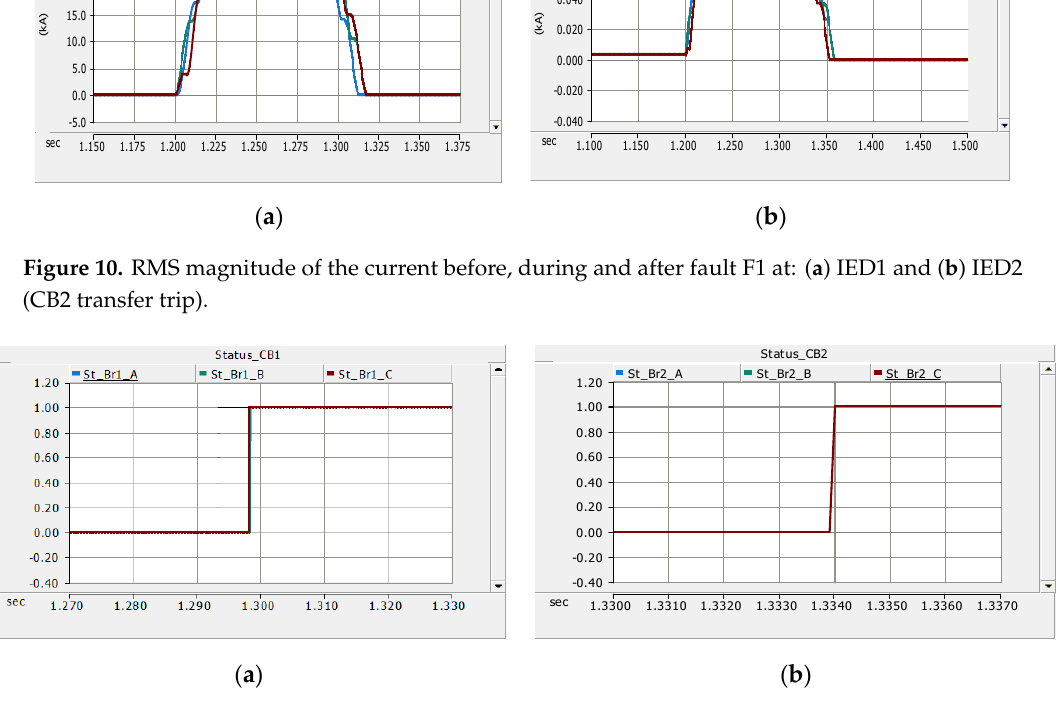
Figure 11. Operating time and status of breakers before, during and after the clearance of fault F1: ( a ) CB1 (main protection trip) and ( b ) CB2 (direct transfer trip). CB Status: 0 = False (NO trip/Close) and 1 = True (YES trip/Open).